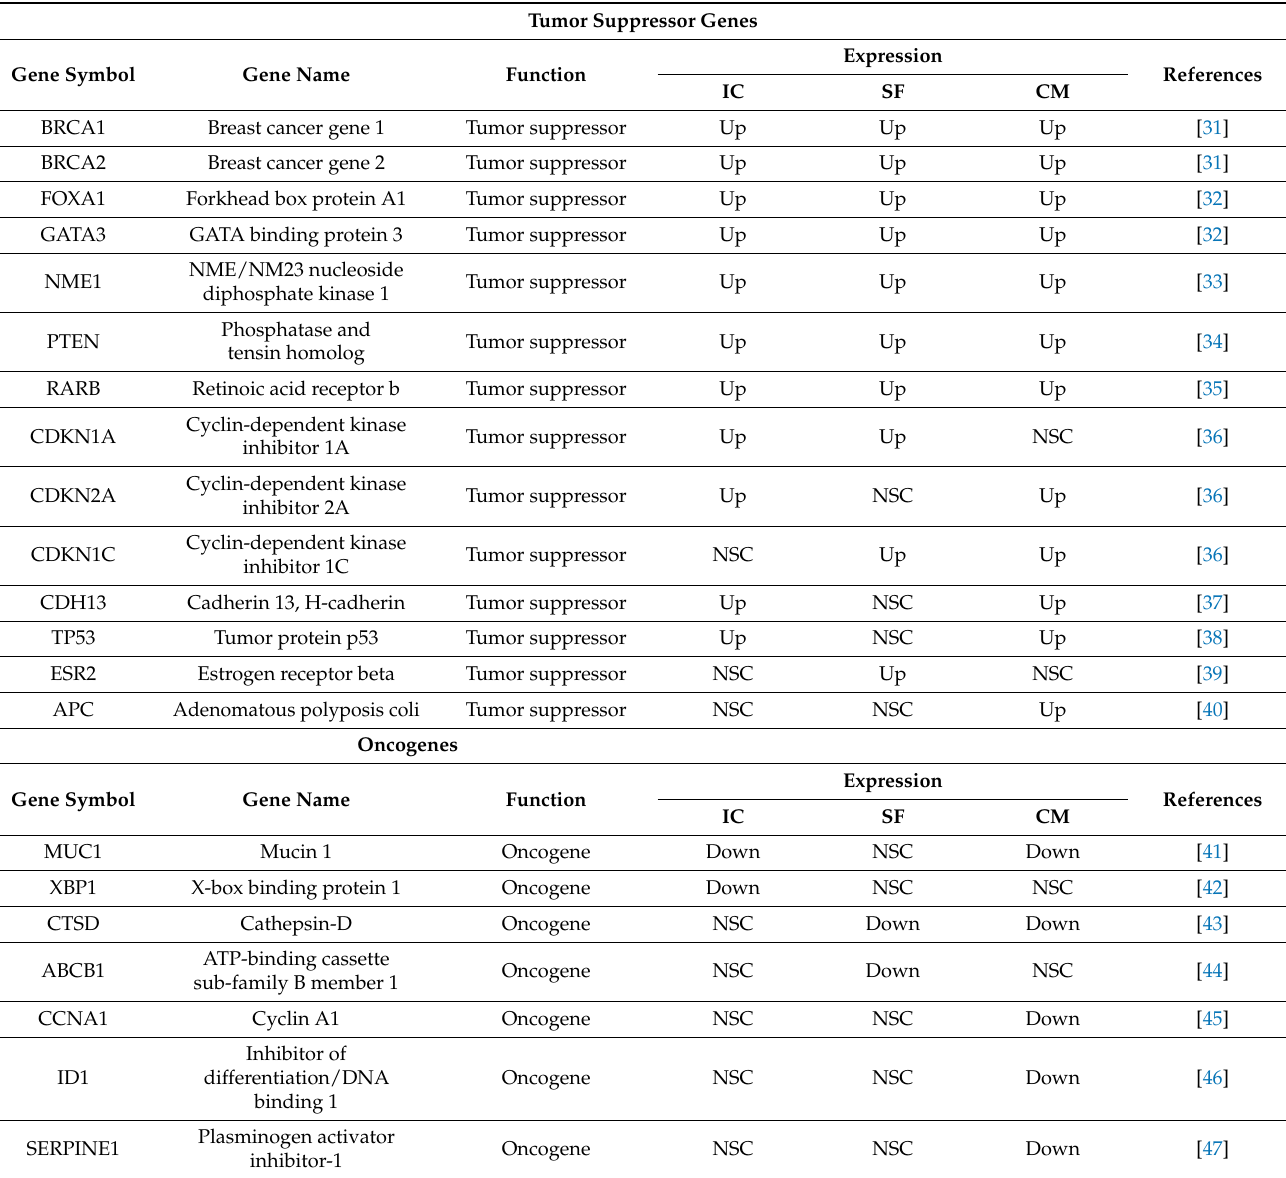
Table 1. The modulation of gene expression in MDA231 cells after treatment with DPMSCs. Tumor Suppressor